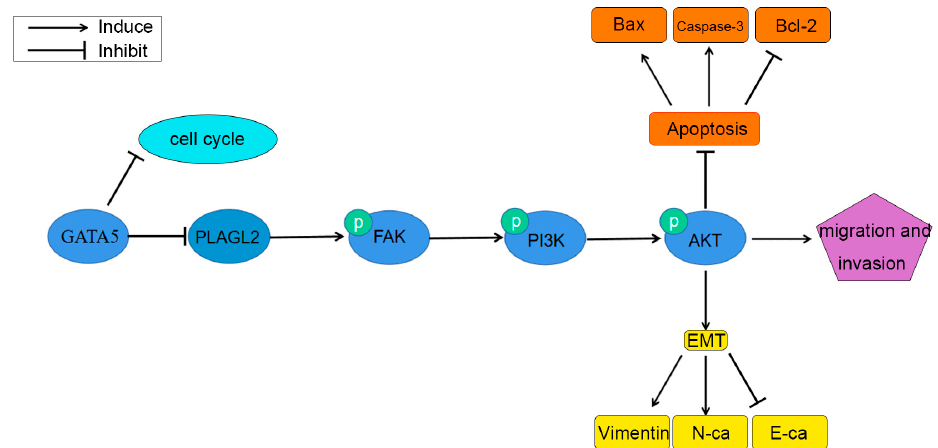
Figure 9. Overexpression of GATA5 inhibits prostate cancer progression by regulating PLAGL2 via the FAK/PI3K/AKT pathway.